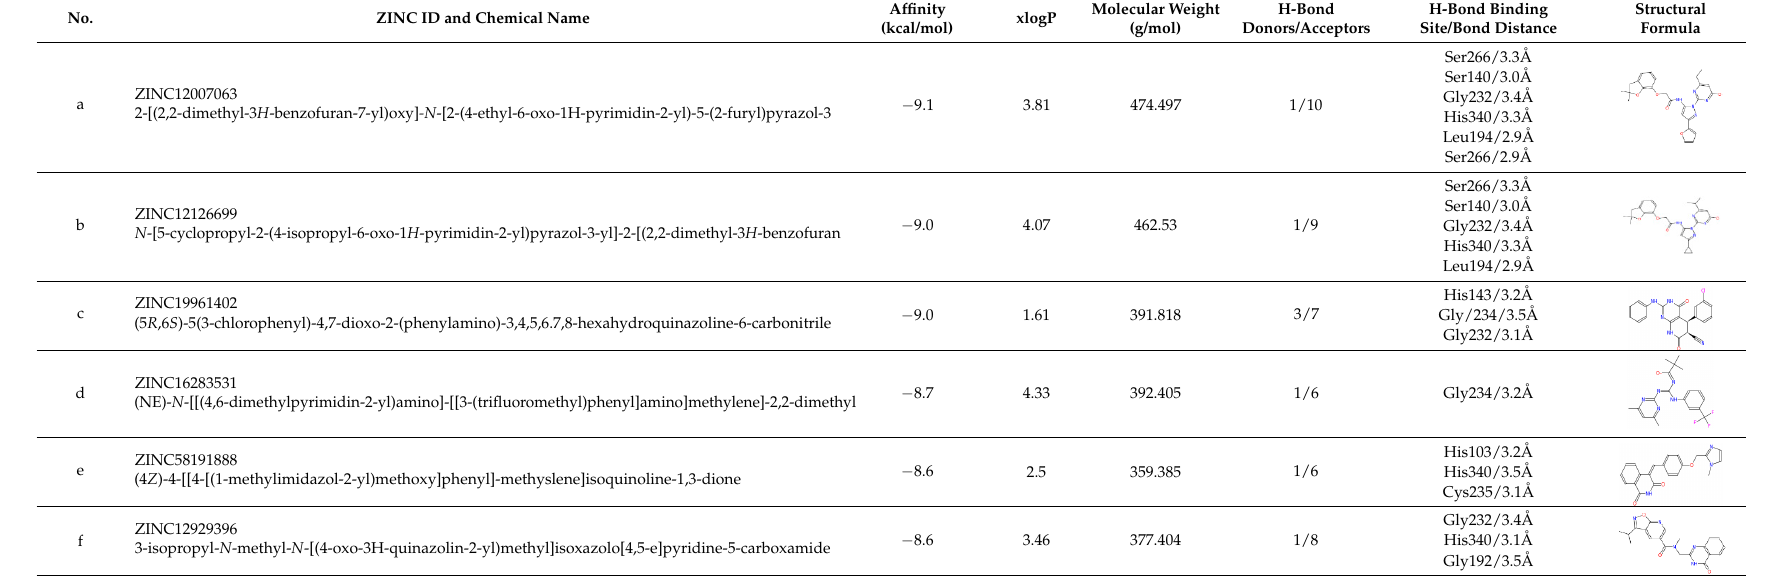
Table 1. The structure of inhibitors which obtained by virtual screening.